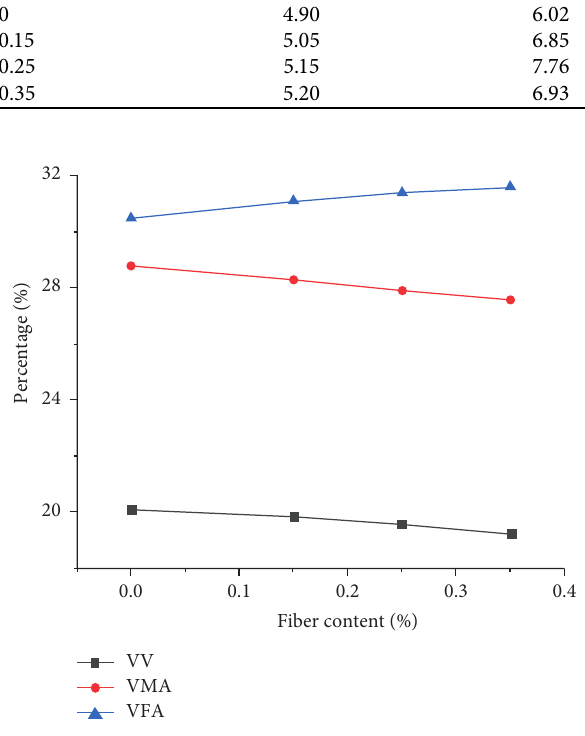
Figure 5: Basalt fiber content-asphalt mixture volume index diagram.